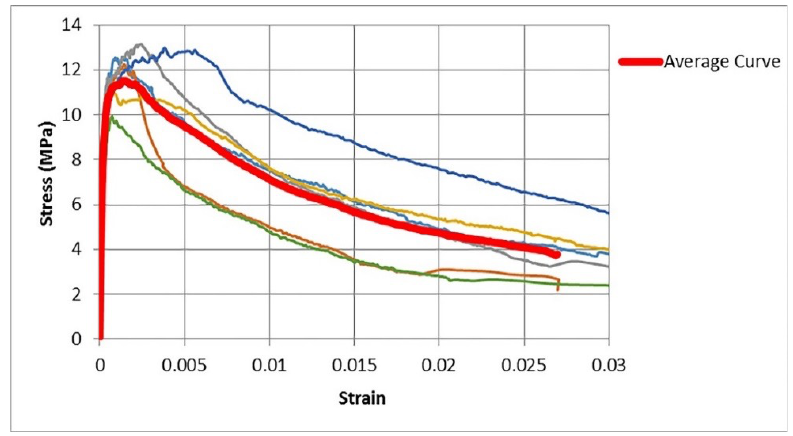
Figure 4. Stress-strain curve from the testing of UHPFRC in tension.